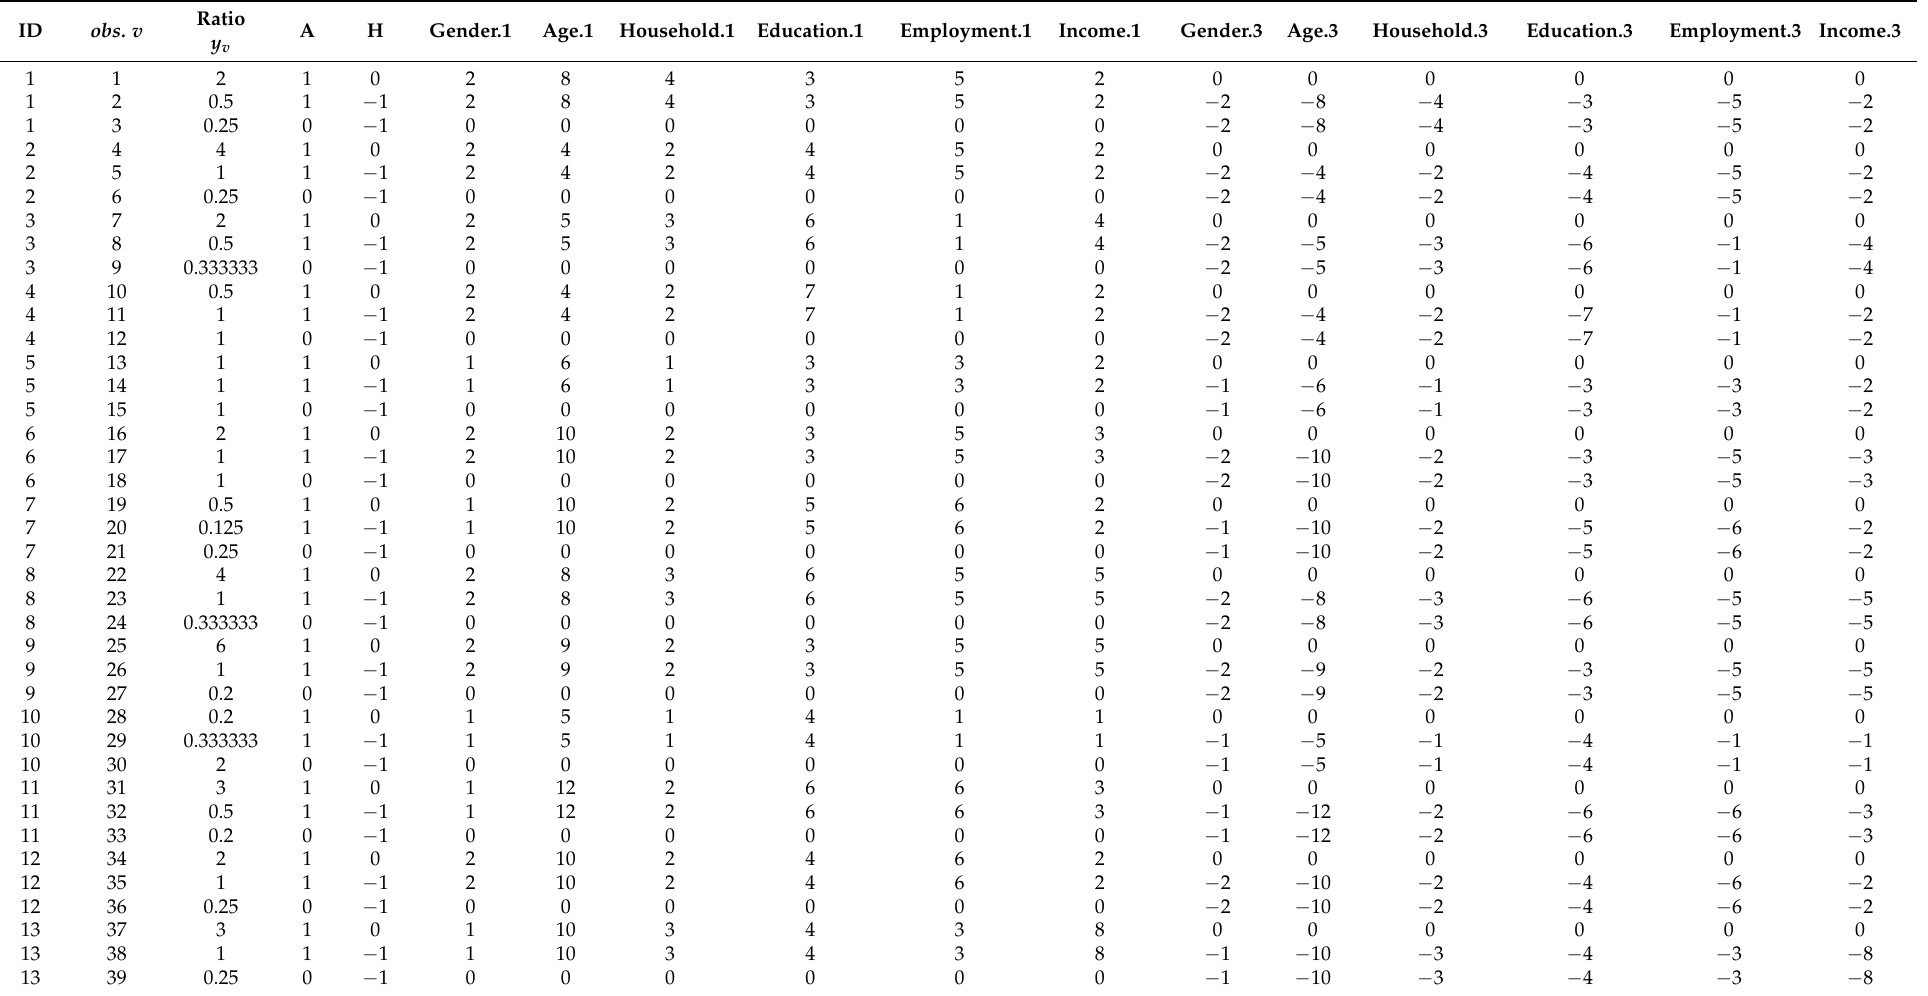
Table 2. AHP and demographic data arranged for regression